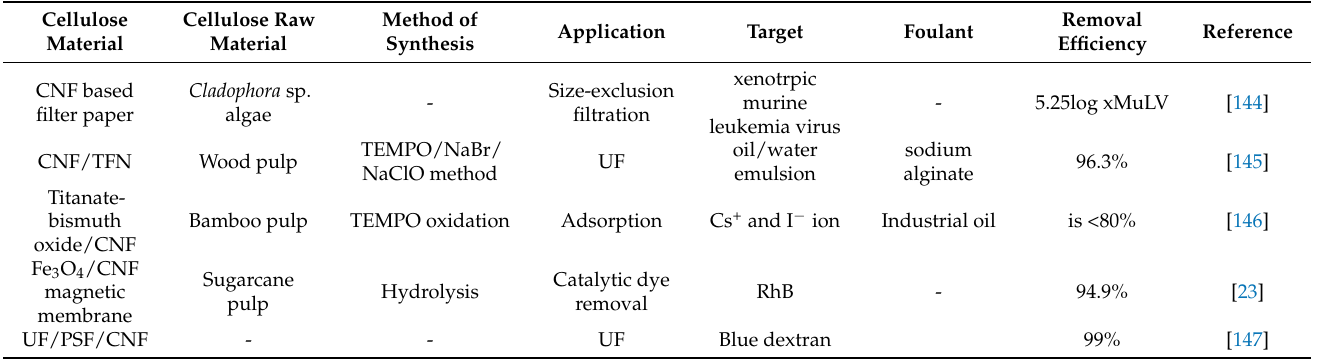
Table 3. The overview of the studies carried out using CNF-based membranes for the desalination and water treatment